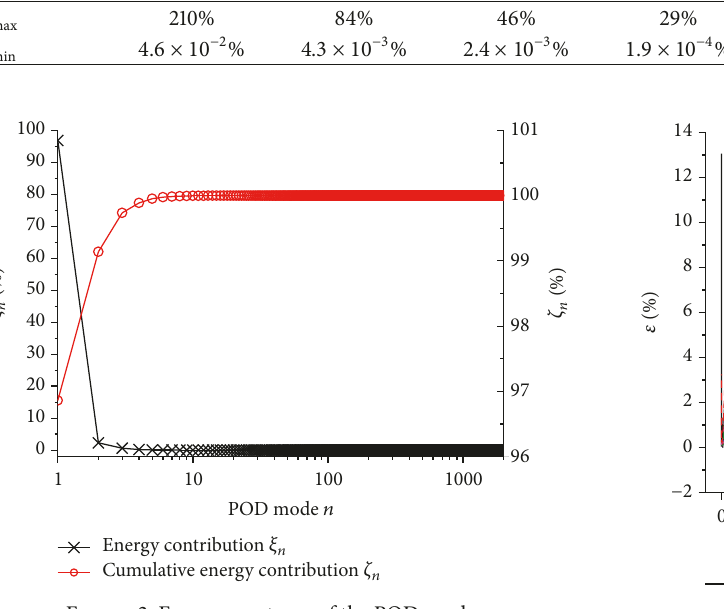
Figure 2: Energy spectrum of the POD modes.